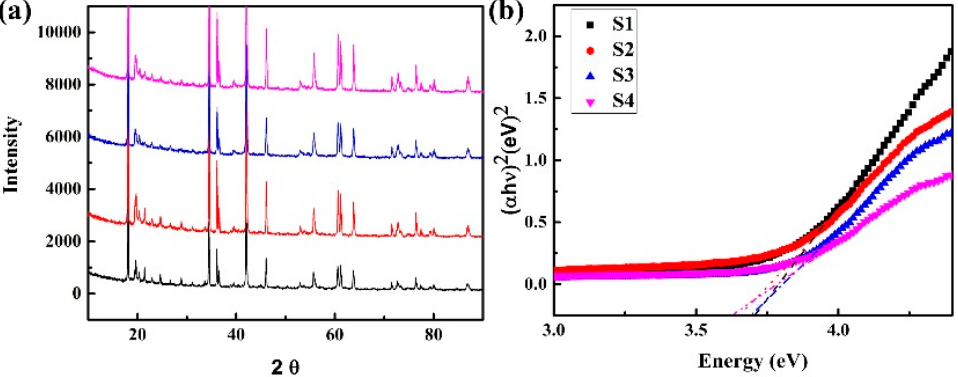
Figure 2. ( a ) Powder X-ray diffraction patterns and ( b ) UV-vis diffuse reflectance spectra of Li 2 SnO 3 samples: S1, S2, S3, and S4.